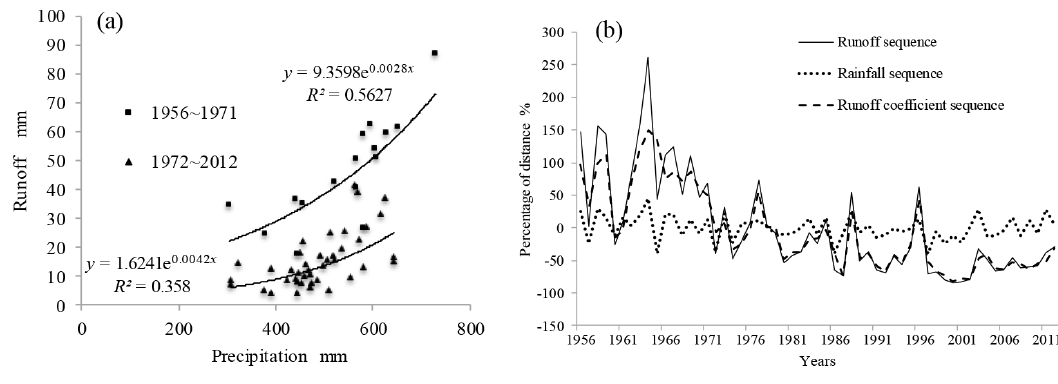
Figure 5. Variation of Precipitation Runoff and Departure from Hejin